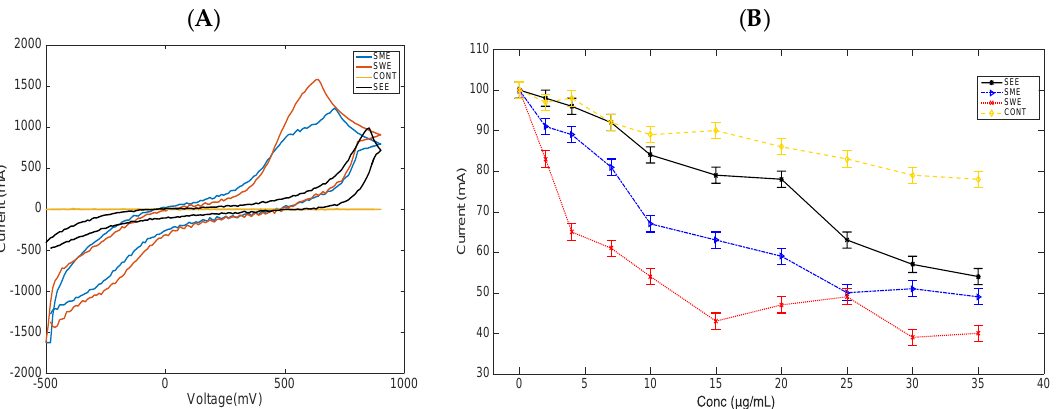
Figure 4. ( A ) Cyclic Voltammetry profile of the extracts without cells showing characteristic anodic signals of the main natural products in the seed water extract (SWE, red), seed methanol extract (SME, blue), and seed ethanol extract (SEE, black), compared with the bare electrode (CONT, yellow). ( B ) Concentration-dependent cell viability studies of the extracts on S. cerevisiae cell lines: SWE, red; SME, blue; and SEE, black, compared with the bare electrode, CONT, yellow. Reproducibility of the data was analyzed using triplicate measurements.